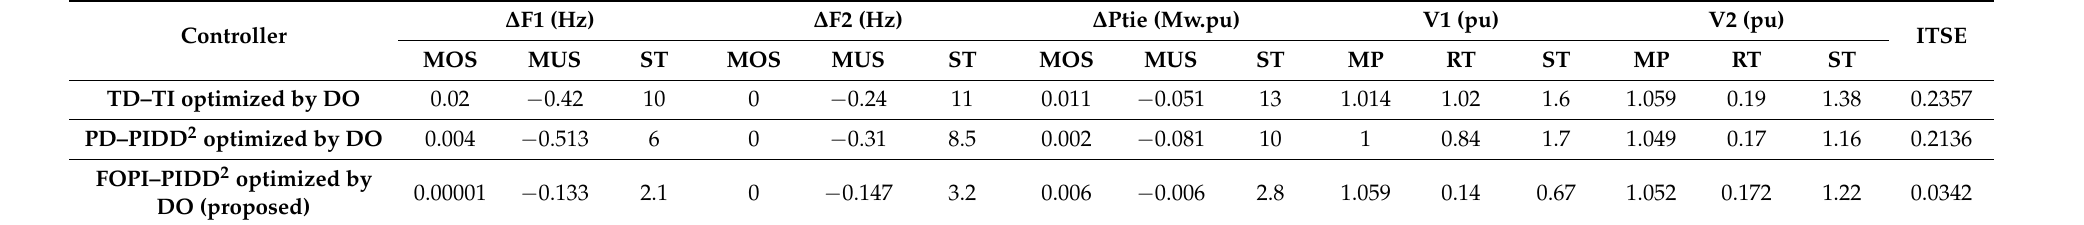
Table 3. Dynamic specifications of the investigated system using different controllers under scenario 1